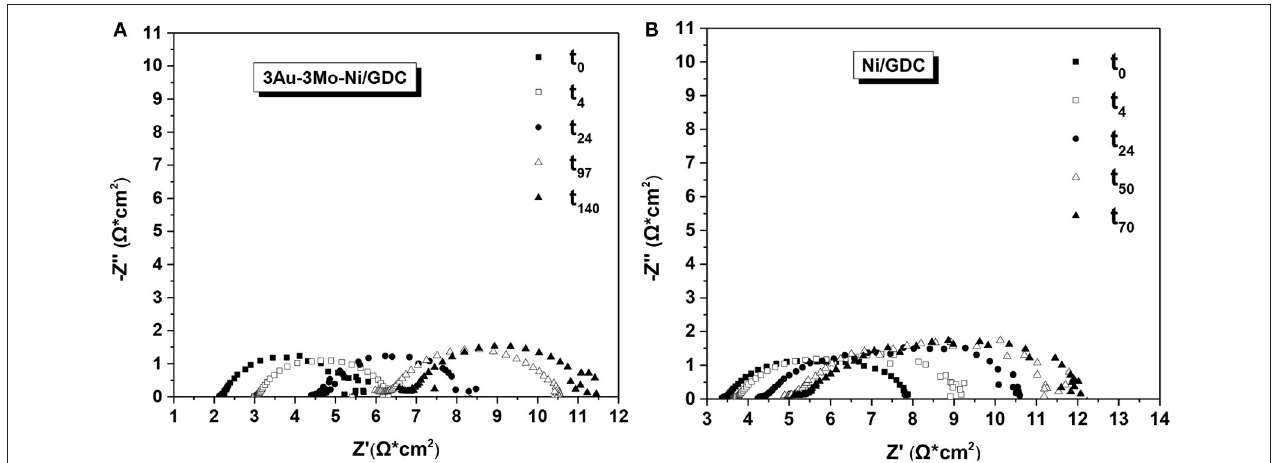
FIGURE 17 | EIS measurements on the cells with (A) 3Au-3Mo-Ni/GDC and (B) Ni/GDC anode electrodes during the stability test (140h) under internal CH 4 steam reforming conditions at T = 800 ◦ C. The spectra were recorded at consecutive time intervals: t 0 = 0h ( (cid:4) ), t 4 = 4h ( ), t 24 = 24h ( • ), t 97 = 97h ( △ ) and t 140 = 140h ( N ), on galvanostatic mode at j = 28 mA/cm 2 . The reaction mixture comprised 22 vol.% H 2 O and 78 vol.% CH 4 with F total = 150 cc/min (S/C = 0.3 without dilution in carrier gas). Reprinted with permission from Neofytidis et al. (in press).